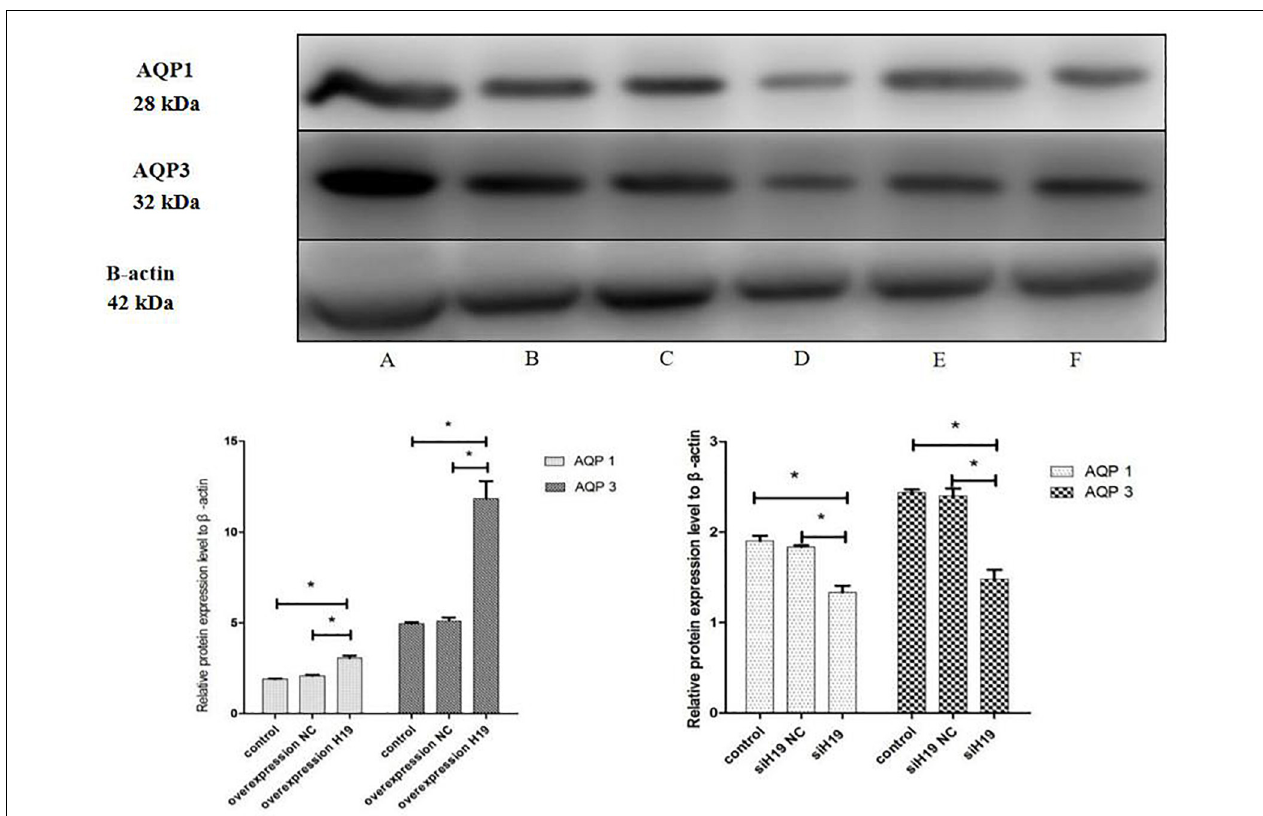
FIGURE 3 | In vitro AQP proteins expression detected using Western blot. In vitro Caco-2 cells models, levels of AQP1 and AQP3 measured by western blot in group A were higher significantly than that in group B and group C. And protein expression in group D was lower than that in group E and group F. * P < 0.05, vs. corresponding control. Group A: H19 over-expression vector group; Group B: over-expression empty group; Group C: over-expression control group; Group D: siH19 interference vector group; Group E: interference empty group; Group F: interference control